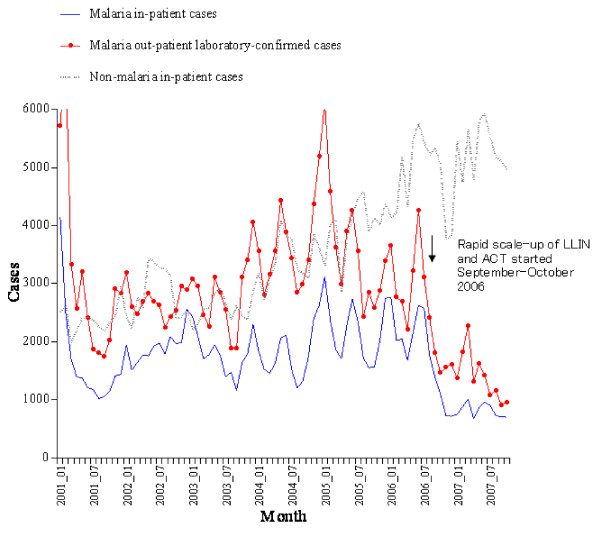
In-patient malaria cases, out-patient laboratory-confirmed cases, and in-patient non-malaria cases, by month, all ages, January 2001 to October 2007, Rwanda. LLIN = long-lasting insecticidal nets, ACT = artemisinin-based combination therapy medicines.